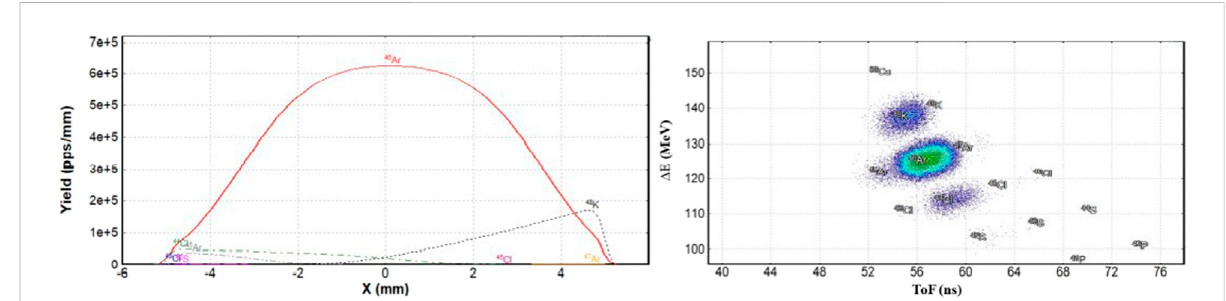
FIGURE 11 Left: simulated spatial distribution at theexit ofthe fragment separator on thehorizontal direction and simulated Δ E-TOF tagging plot (right), in the case of 48 Ca 20+ at 50 AMeV primary beam and for a tuning of the fragment separator maximizing the 46 Ar production. For the sake of clarity, only the main contaminants are shown in the spatial distribution